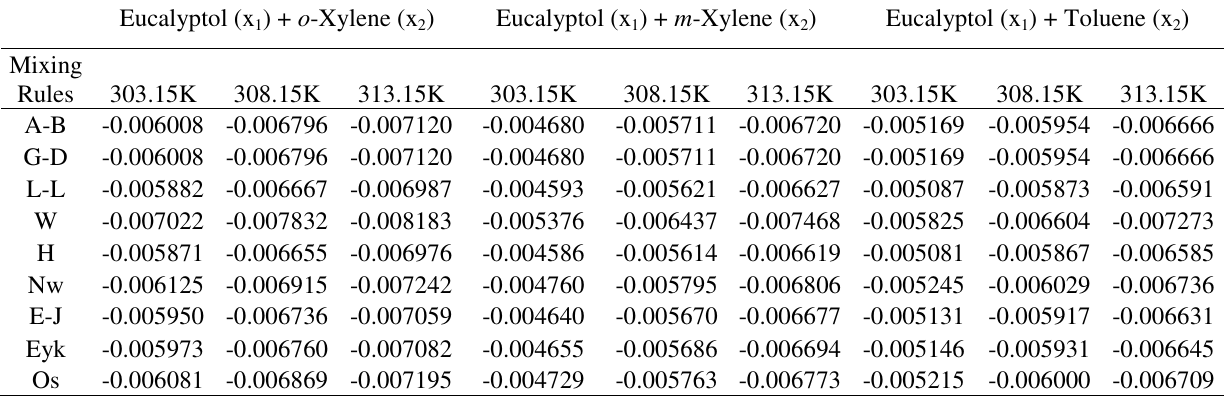
Table 3. Average deviations* in the Refractive Index from different mixing relations for Eucalyptol + Hydrocarbon binary mixtures at 303.15 K, 308.15K and 313.15